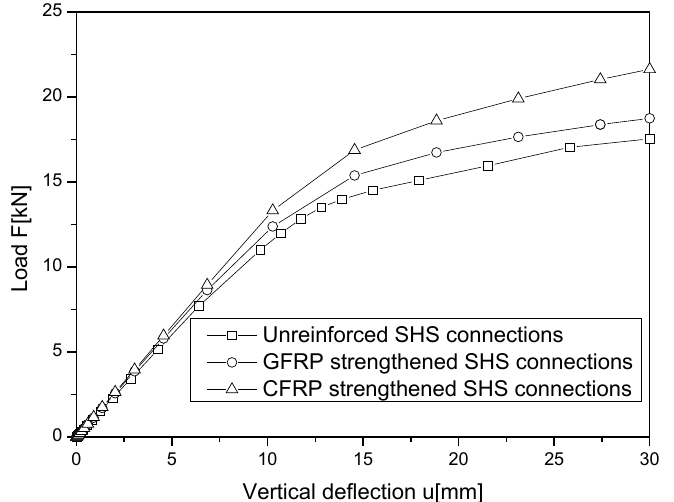
Figure 8. Simulated force displacement curves for the connection under static loading.